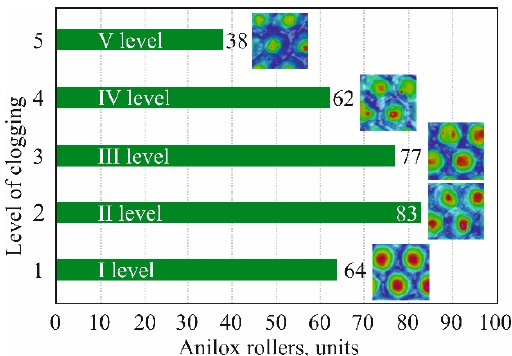
Figure 9. Distribution of anilox rollers according to the level of clogging.